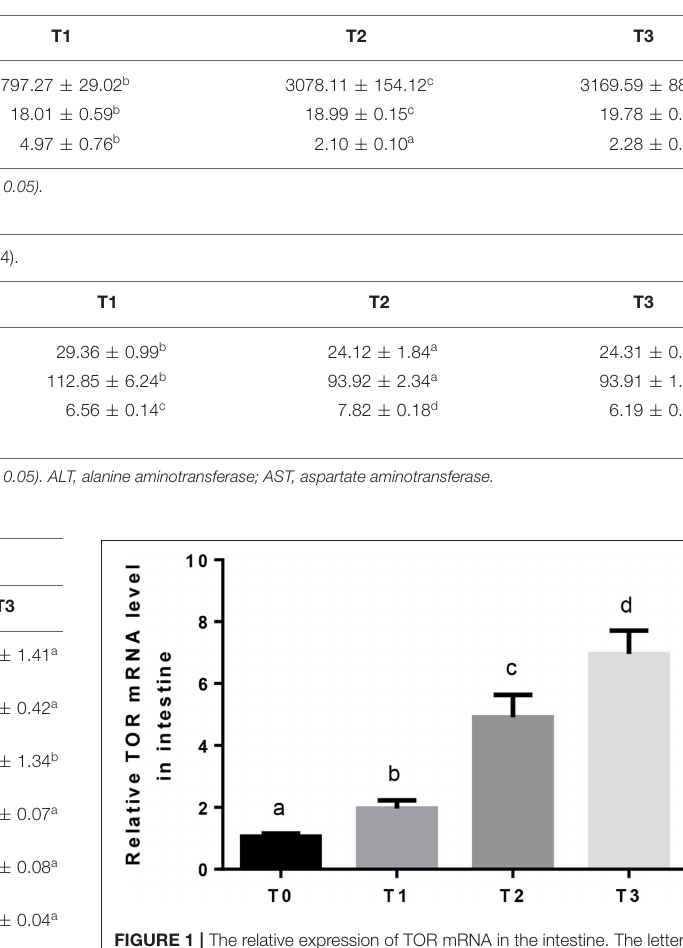
TABLE 7 | Digestive enzyme activities (Umg − 1 protein) in intestine of grass carp (means ± SD, n = 4).